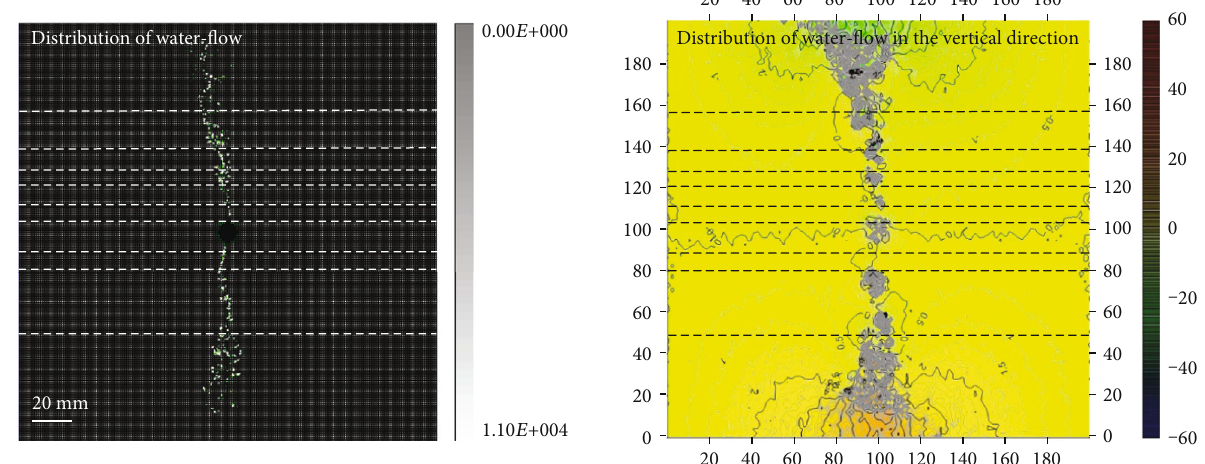
Figure 4: Distributions of water fl ow and its vertical